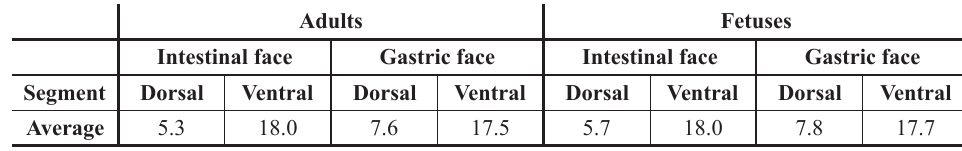
Number of segmentary branches in spleen of equine adult and